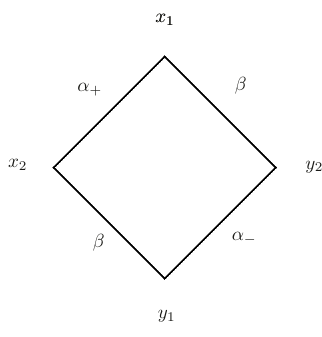
Figure 5 . Diagrammatic representation of the R (cid:0) operator (2.14). Solid line with index (cid:11) stands for 1 = ( x 2 ) (cid:11) . The values of indices depend on the spectral parameter and are given by (cid:11) + = (cid:0) 1 (cid:0) u , (cid:11) (cid:0) = 1 (cid:0) u and (cid:12) = 2 + u